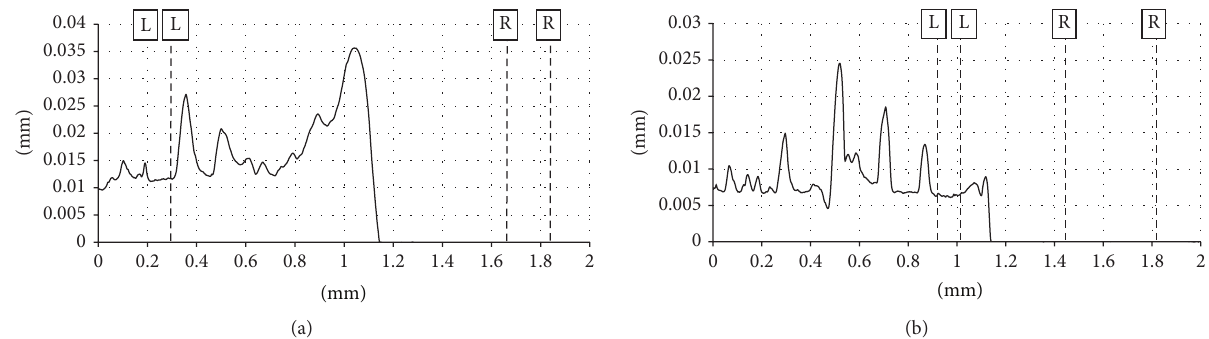
Figure 8: (a) Thickness and surface roughness of untreated TiO 2 thin film by Surface Profiler (width = 1567.8 𝜇 m, height = − 11.487 𝜇 m, TIR = 35.649 𝜇 m). (b) Thickness and surface roughness of treated TiO 2 thin film by Surface Profiler (width = 654.72 𝜇 m, height = − 6.2984 𝜇 m).